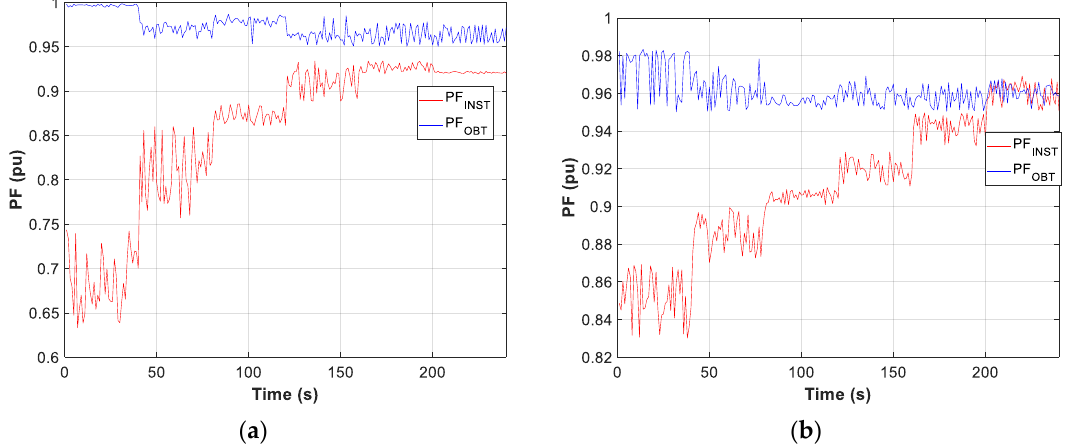
Figure 8. Comparison of power factor installation (PF INST ) vs power factor obtained (PF OBT ): ( a ) Motor in W; ( b ) Motor in D.